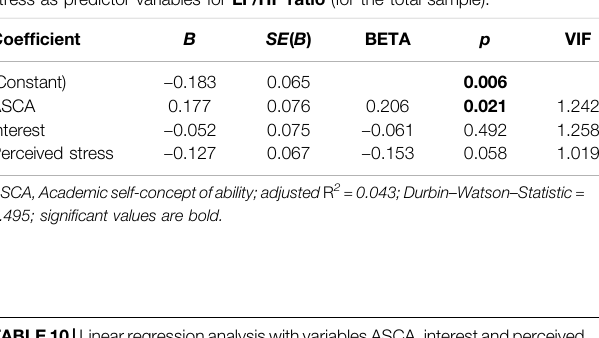
TABLE10| LinearregressionanalysiswithvariablesASCA,interestandperceived stress as predictor variables for RMSSD (for the total sample). Coef fi